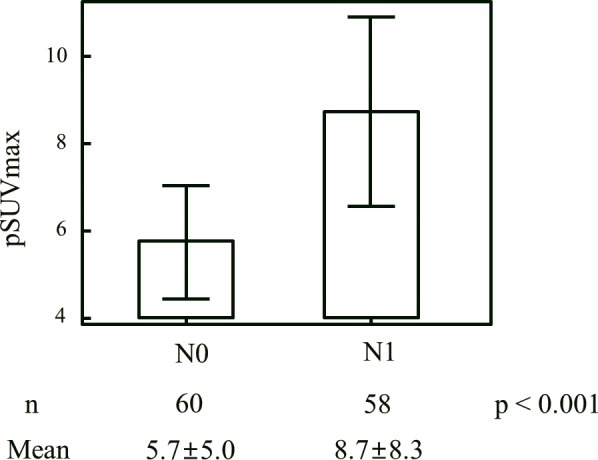
Relationship between SUVmax of primary tumor (pSUVmax) and lymph node metastasis.Fig 1 shows that the pSUVmax was associated with both LN metastasis (p < 0.001) in the FDG avidity group (n = 118).